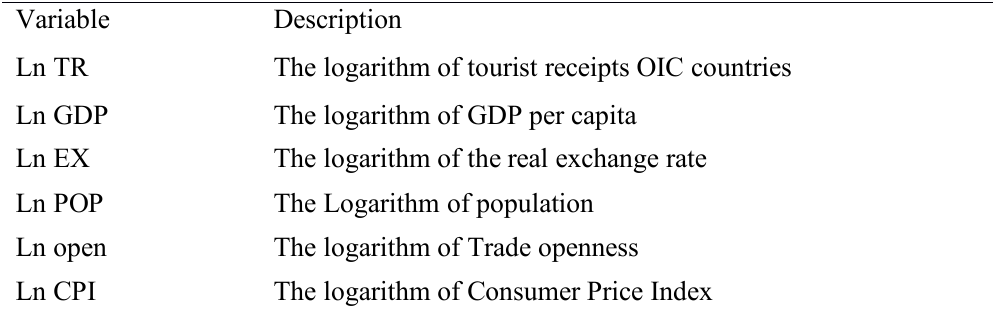
Table 1 . variables of the research model